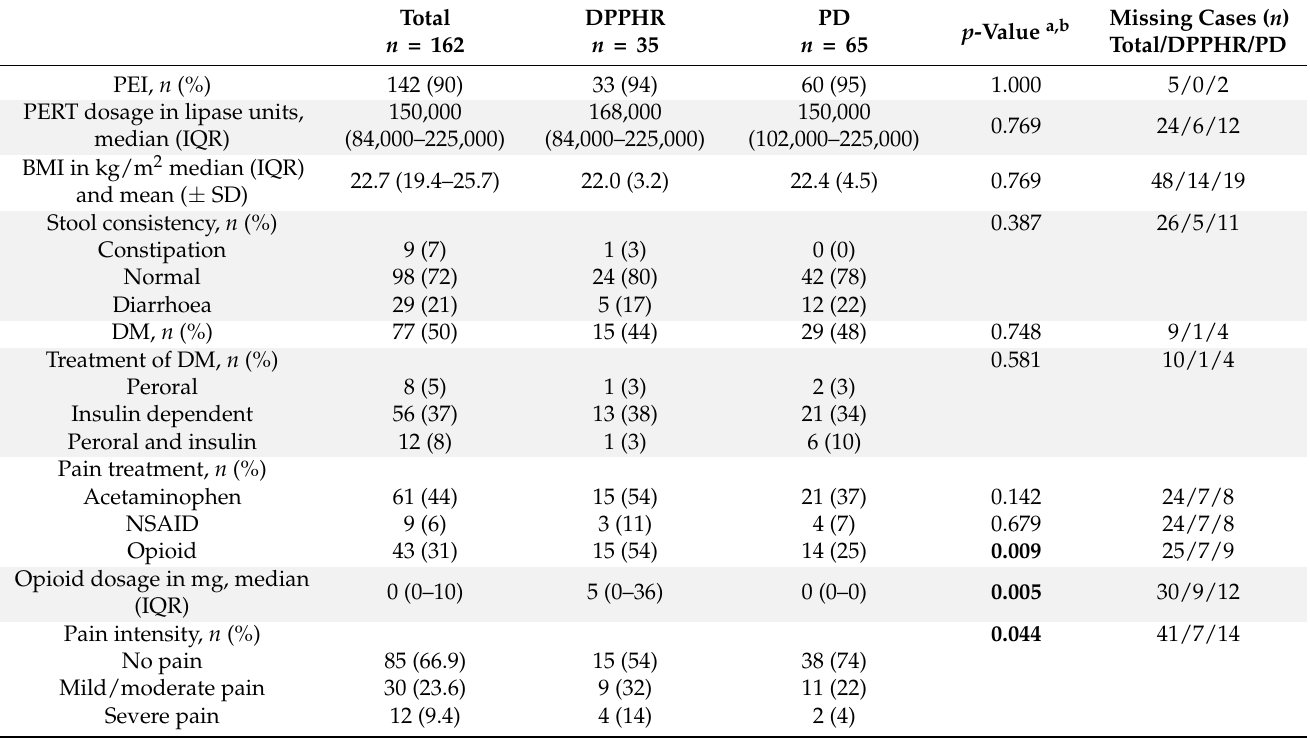
Table 3. Medium-term outcomes at the 6-month follow-up.